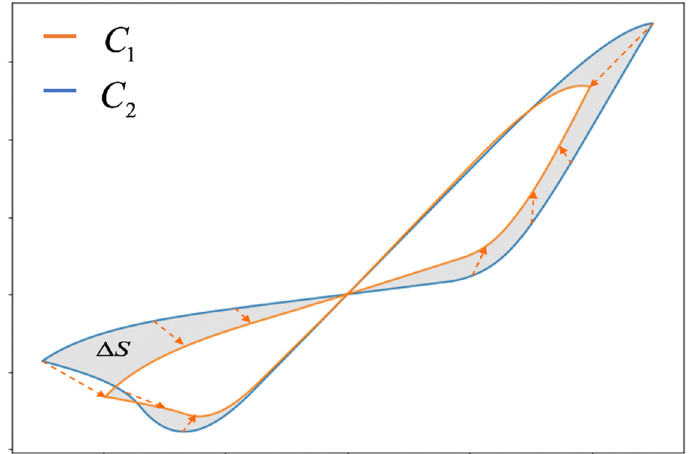
Figure 2. Schematic representation of the absolute symmetric difference of the area of figures ∆ C ) limited by contours 𝐶 𝑆(𝐶 ) limited by contours C (cid:2869) Δ𝐶 (cid:2870) 2